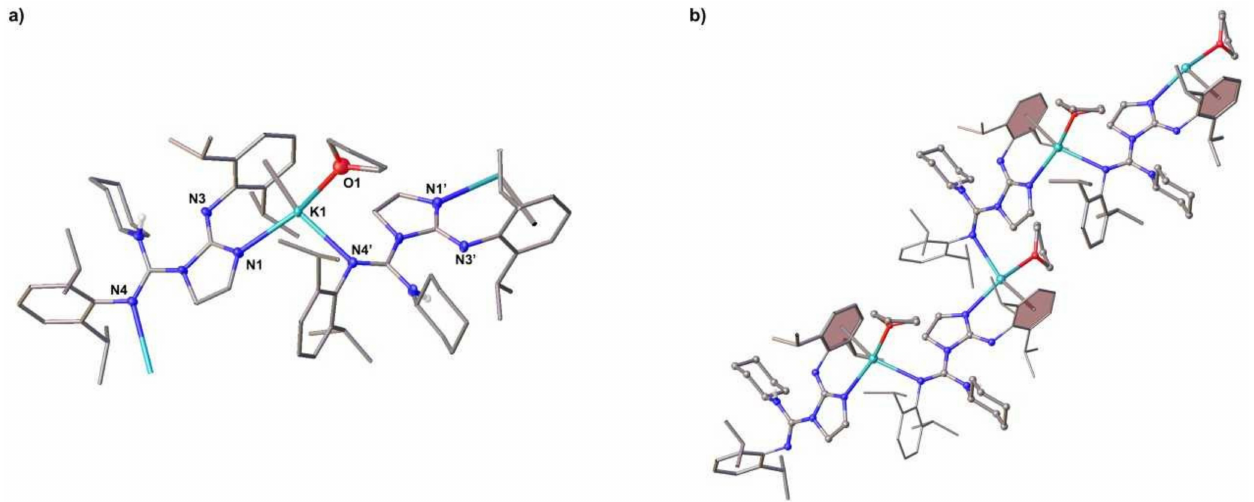
Figure 3. ( a ) Solid-state structure (hydrogen atoms except the NH are omitted for the sake of clarity) with selected bond lengths (Å) and angles (deg) of 3 : K1–N1 2.695(2), K1–N4 (cid:48) 2.735(2), K1–O1 2.776(2), K1–Ph-Ring 2.857(2), N1–K1–N4 (cid:48) 103.06(7), N4 (cid:48) –K1–O1 85.88(7); symmetry transformations used to generate equivalent atoms (marked with an ‘): − x + 3/2, y + 1/2, − z + 3/2. ( b ) 1D coordination polymer of 3